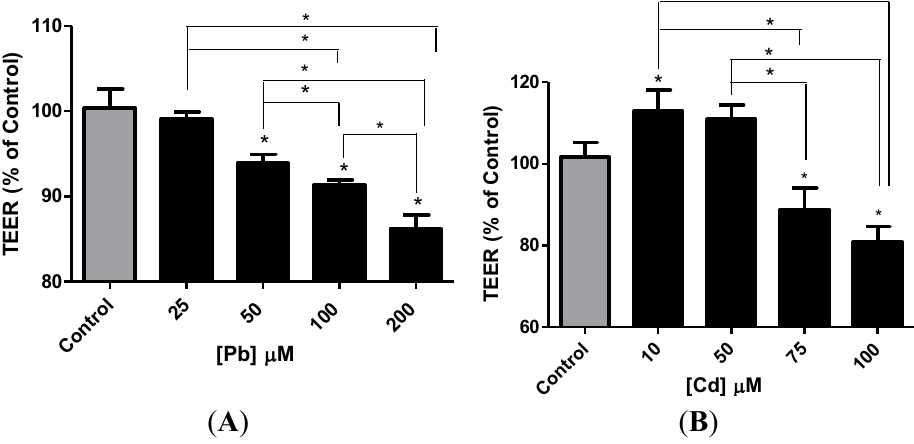
Figure 5. Effects of ( A ) Pb and ( B ) Cd on TEER in hCMEC/D3 cells. hCMEC/D3 cells were seeded onto a collagen-coated insert with a pore size of 0.4 μm at a density of 15 × 10 3 cells/well, and allowed to culture until a monolayer formed. The cell monolayer was then treated with different concentrations of Pb (25–200 µM) and Cd (10–100 µM) for 48 h and 24 h, respectively. Values represent mean ± SD. All experiments were performed in triplicates, and the values reported are mean ± SD ( * over the test column represents p < 0.05 compared to the control, and on the linking lines represents p < 0.05 between the two test groups).